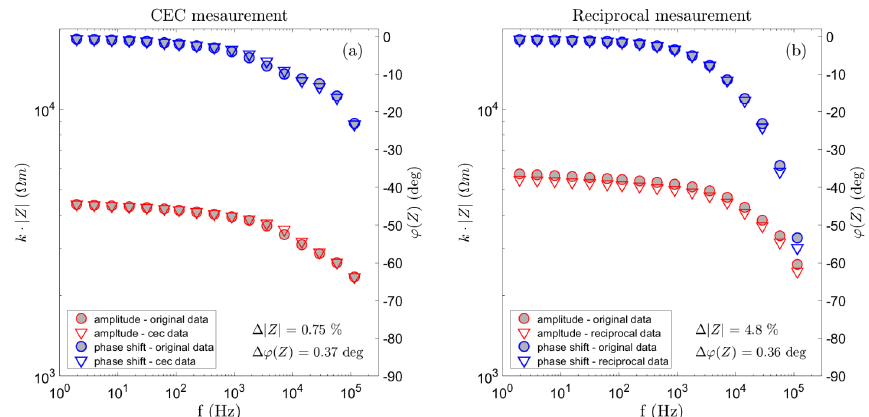
Figure 3. (a) Impedance magnitude and phase spectra from the survey at Yakutia, recorded with and without CEC compensation. The data were measured in a dipole-dipole configuration with a = 2m and n = 8. (b) Impedance magnitude and phase spectra from a survey at an alpine permafrost site. The data were measured with a = 2m and n = 5 in original and reciprocal dipole–dipole configuration. The amplitude and phase data are shown in red and blue colours,